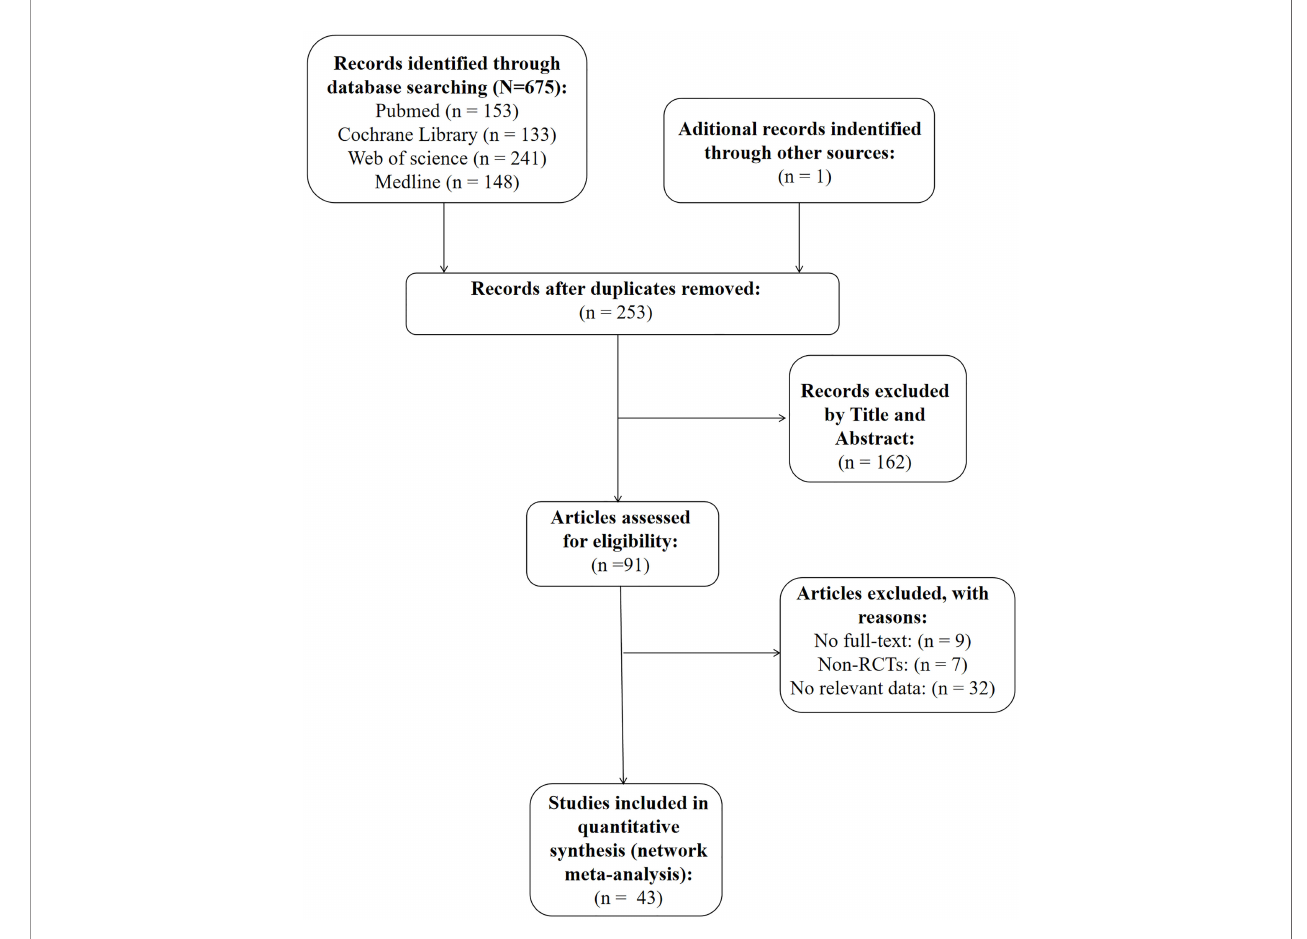
FIGURE 1 | Flow diagram of assessment of